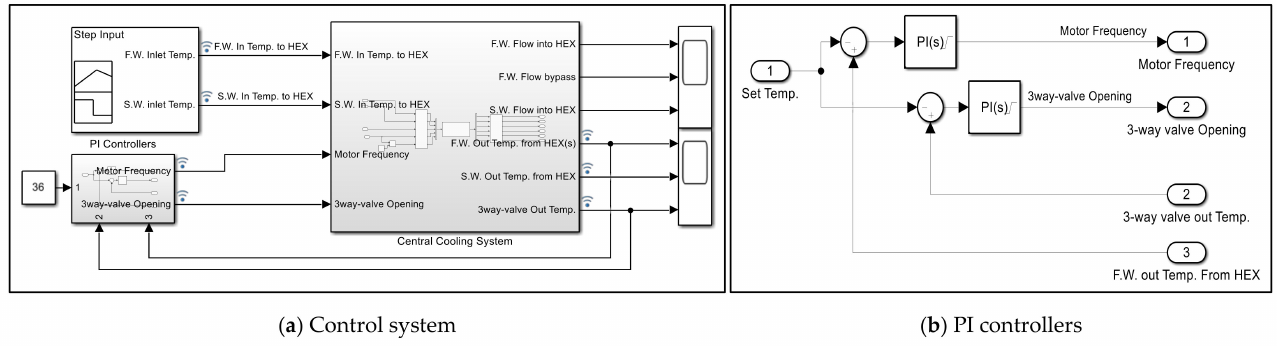
Figure 19. Control system configuration with separated feed-back signals. ( a ) Control system; ( b ) PI